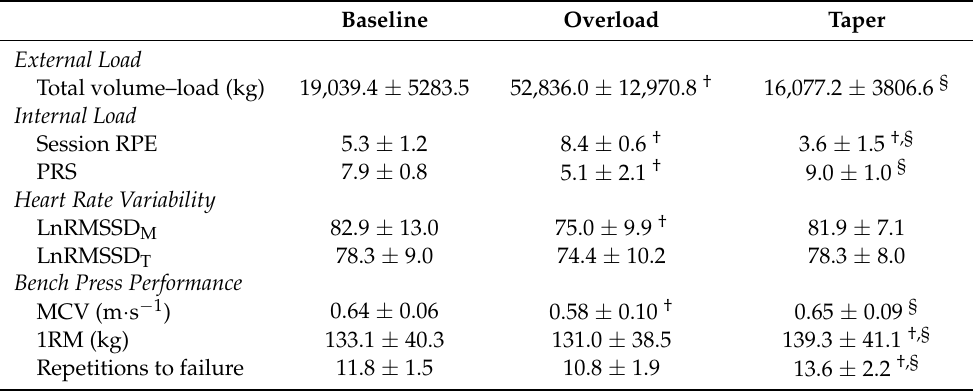
Table 2. The comparison of the external load, internal load, heart rate variability and bench press performance across microcycles (n = 12).